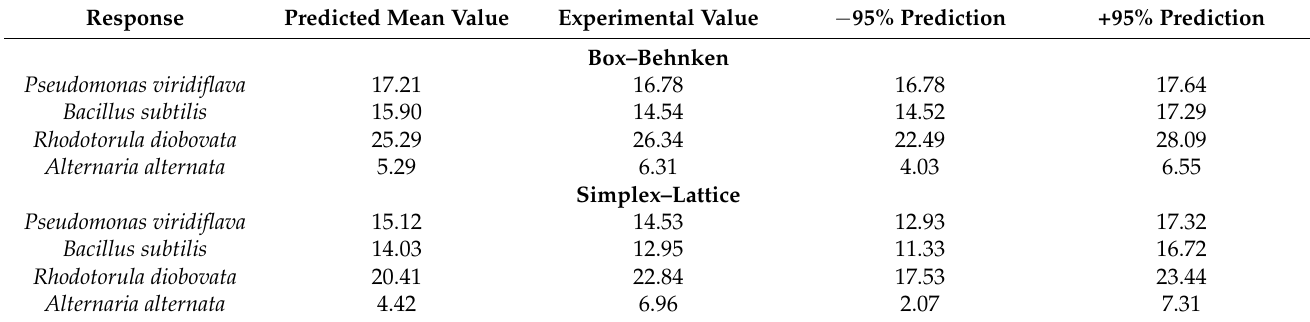
Table 8. Validation of predicted and experimental values for the inhibitory activity (mm) of the two optimised extract blends ( n =